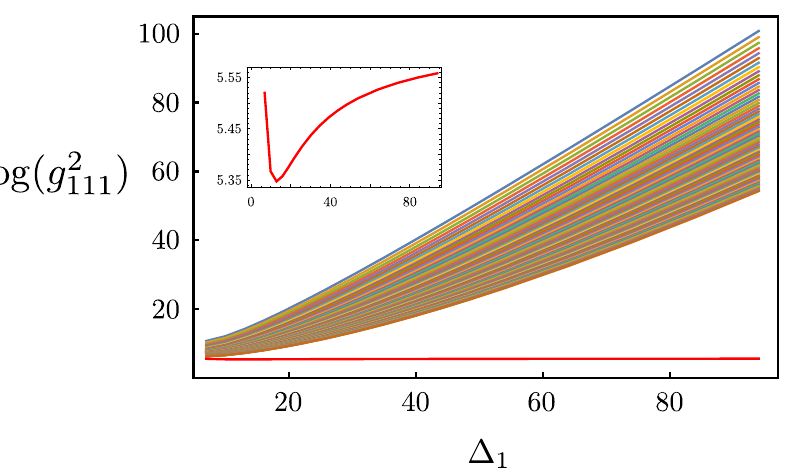
Figure 8 . Upper bound on log( g 2 ) as a function of (cid:1) 1 , for a gap (cid:1) b = 1 : 85(cid:1) 1 in scenario II. 111 The di(cid:11)erent curves correspond to di(cid:11)erent numbers of derivatives N ranging from 40 (top) to 300 (bottom). Each curve is an upper bound, which gets stronger as N increases. In red we show the extrapolation to in(cid:12)nite N , enlarged in the inset. It varies relatively little and seems to asymptote to a constant at large (cid:1) 1